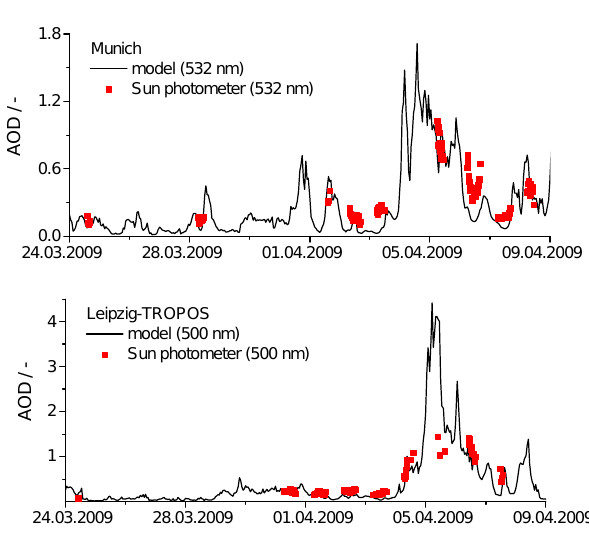
Figure 7. Time series of AOD from AERONET sun photometer measurements with model values shown as straight